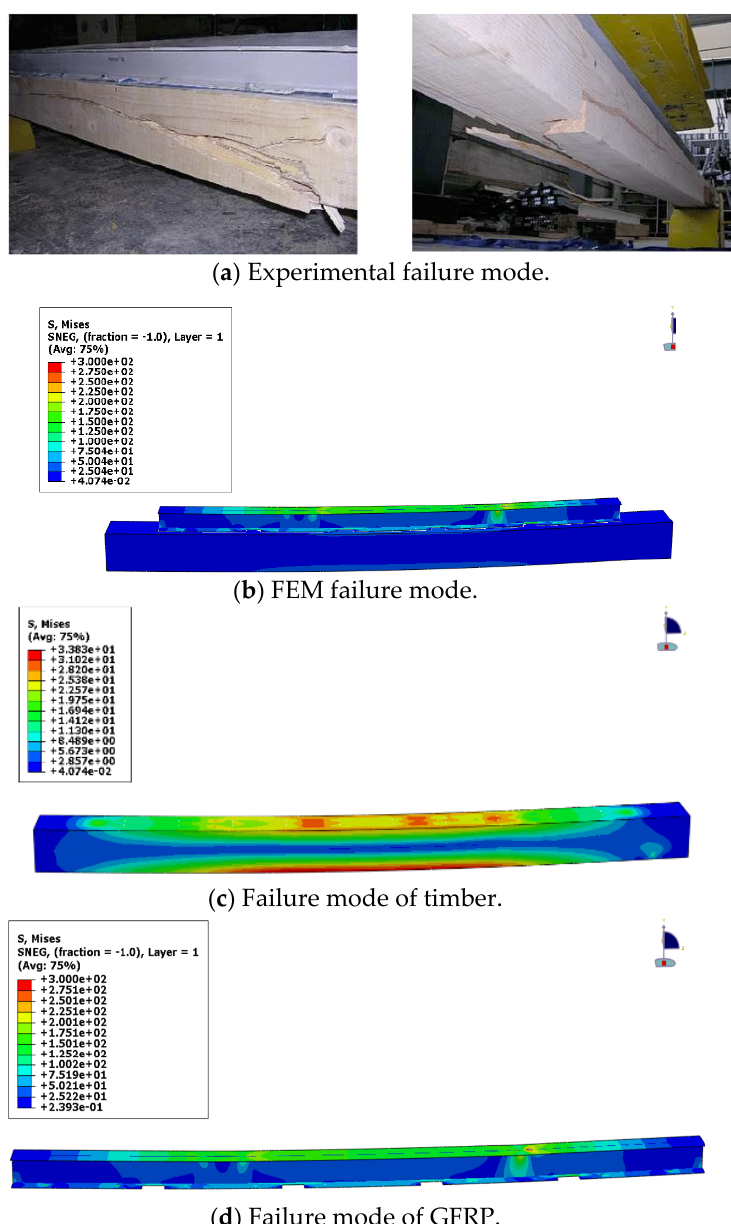
Figure 14. Failure mode of the bare GFRP pultruded profile subject to flexure from FEM (stress values are in MPa).